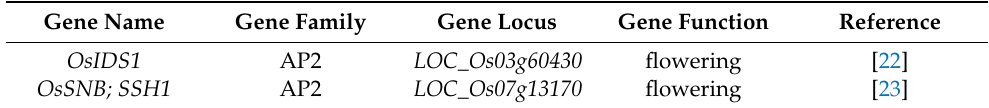
Figure 2. Schematic representation of spikelet development, flowering time and grain properties mediated by AP2/ERF transcription factors in rice. OsIDS1 , SNB/SSH1 , MFS1 and FZP , which are mentioned in Section 3.1, inhibit spikelet indeterminacy. Of these, OsIDS1 and SNB/SSH1 are mentioned in Section 3.2 to inhibit flowering. In Section 3.3, SHAT1 and SNB/SSH1 are mentioned to promote grain shattering. FZP and OsERF115 promote grain size, while SNB/SSH1 , RSR1 and SERF1 inhibit grain size. SERF1 inhibits starch content, and RSR1 affect amylose content and amylopectin structure. The AP2/ERF transcription factors and other regulators are shown in red and black, respectively. Table 2. The genes associated with spikelet determinacy and organ development in rice. Table 3. Genes associated with flowering in